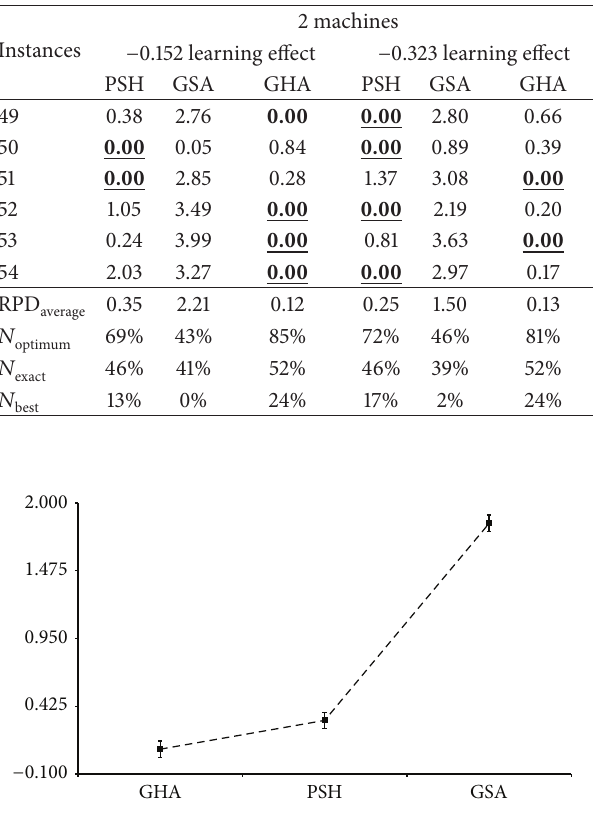
Table 4: Results of 2 machines benchmarks.